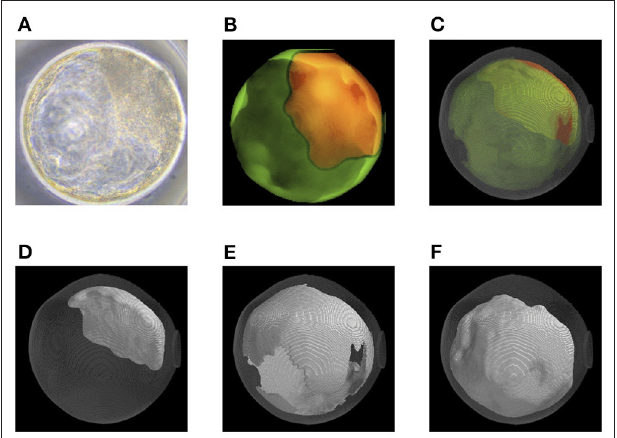
FIGURE 7 | Representative optical coherence tomography (OCT) images of a transferred bovine embryo that resulted in non-pregnancy. (A) A representative transferred embryo, determined as Code 1 according to the IETS standards, imaged by a microscope. (B) Sum of all pixel values in z-stack images of the trophectoderm (TE; bright green) and inner cell mass (ICM; orange) part was extracted from the tomographic image and synthesized 2D image. (C) A 3D-visualization of structures of the embryo, including ICM (orange), TE (bright green), zona pellucida (ZP; gray), and blastocoel. (D–F) A 3D visualization of each structure of the embryo: ICM (D) , TE (E) , and blastocoel (F) . Colors in (B–F) are graphically added. See also Supplementary Movies 5 – 8 for the 3D images of (C–F) ,